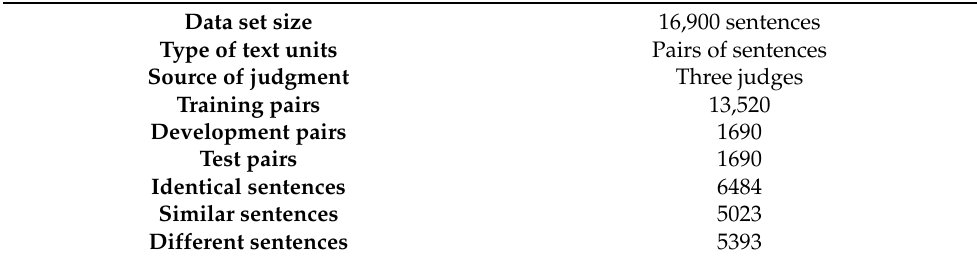
Table 2. Key statistics of the CSE-Persistence corpus.